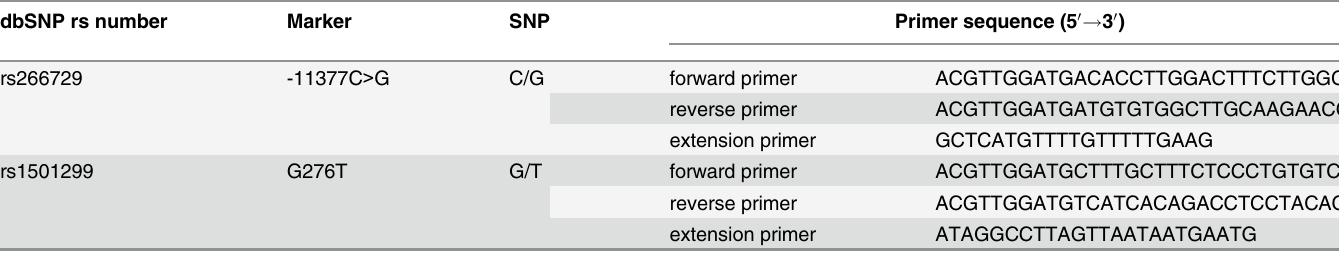
Table 1. SNP amplification and extension primer